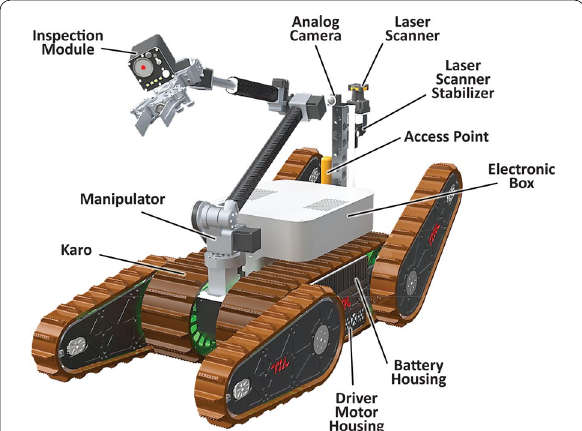
Fig. 6. 3D model of Karo in